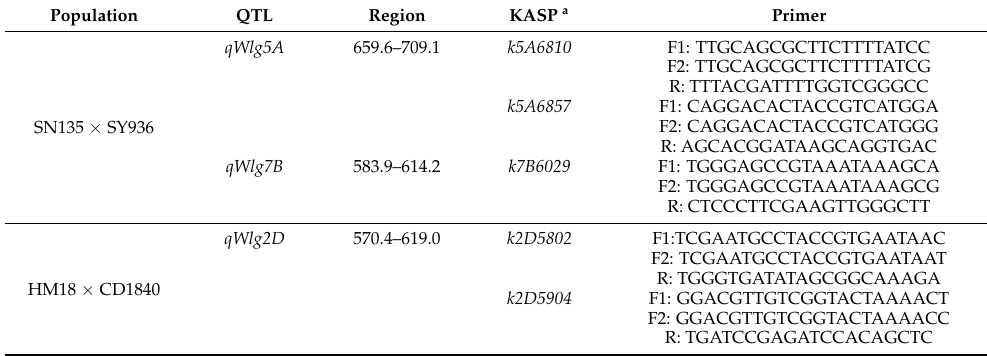
Table 2. QTL region identified for waterlogging tolerance on chromosomes 5A and 7B, and their corresponding linkage KASP markers.